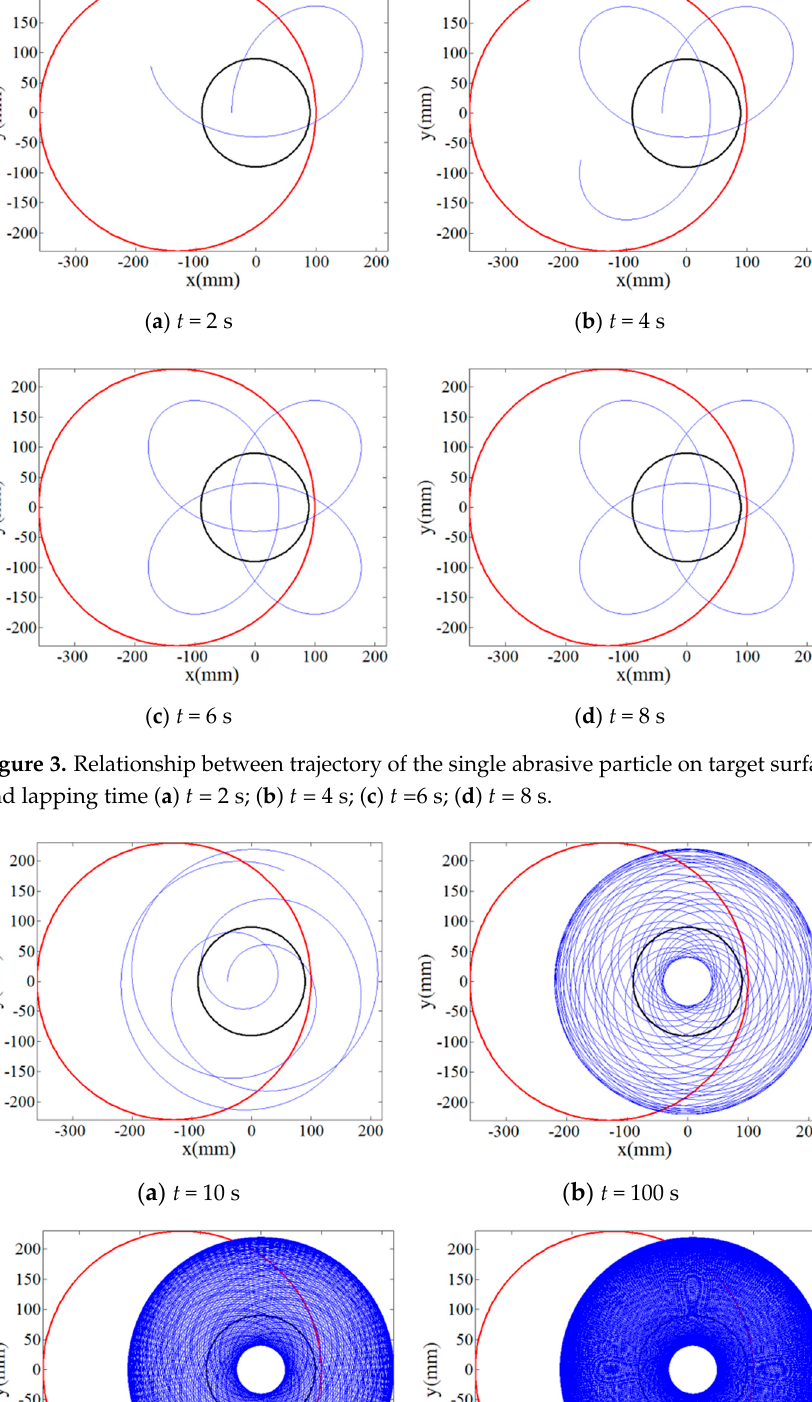
Figure 2. Relationship between trajectory of the single abrasive particle on target surface at i pw = 1 and lapping time ( a ) t = 2 s; ( b ) t = 4 s; ( c ) t =6 s; ( d ) t = 8 s (red lines represent the profile of the lap- ping plate, black lines represent the profile of the workpiece, and blue lines represent the trajec- tory of the single abrasive particle on the target surface).